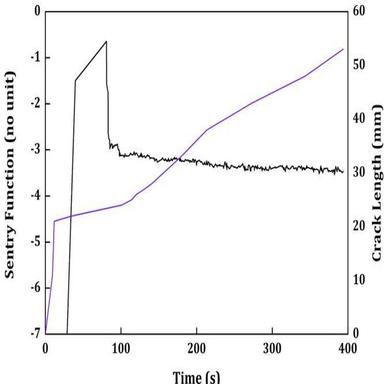
Sentry function and crack length progression for specimen B.